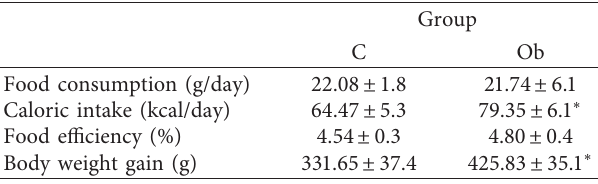
Table 1: Nutritional profile during the 16-week experimental protocol prior to strength